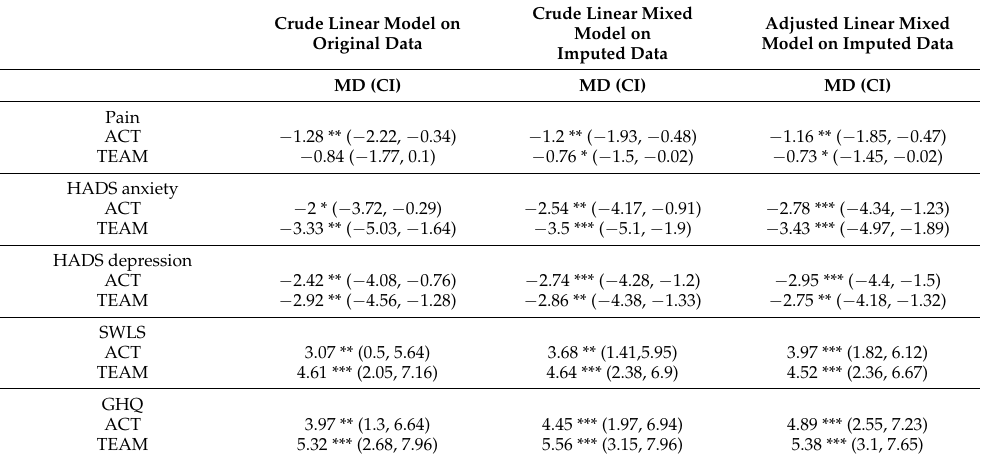
Table 3. Estimated differences in means for intervention groups compared with control at 12